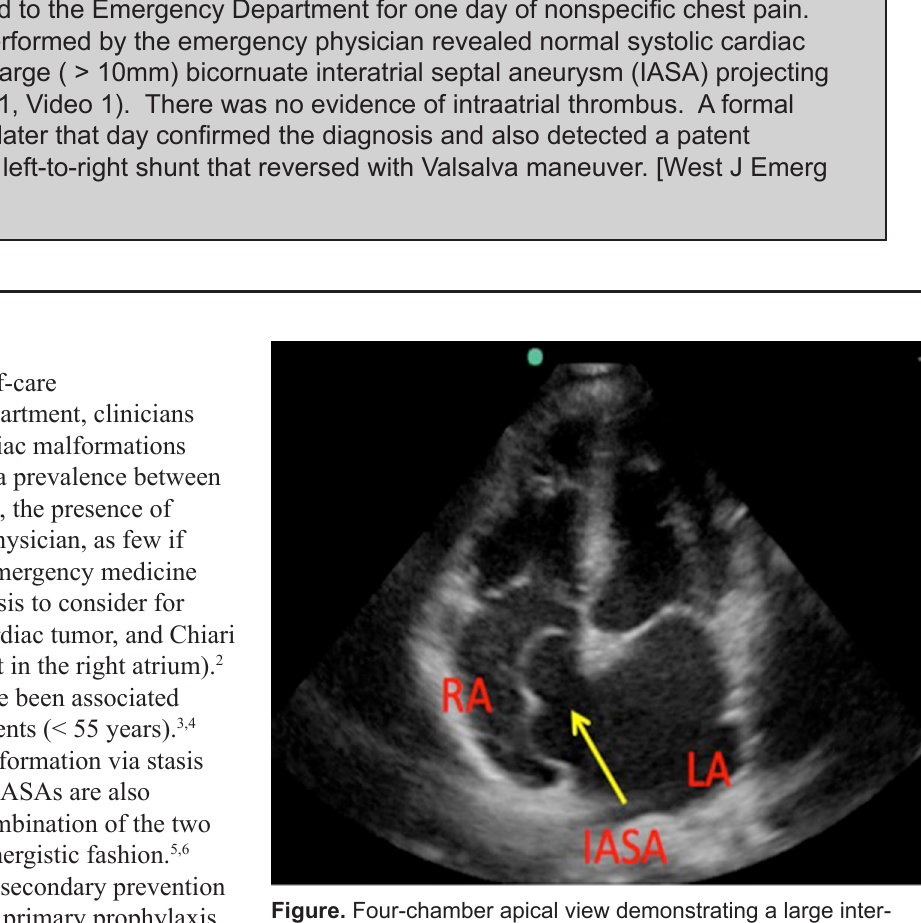
Figure. Four-chamber apical view demonstrating a large inter- atrial septal